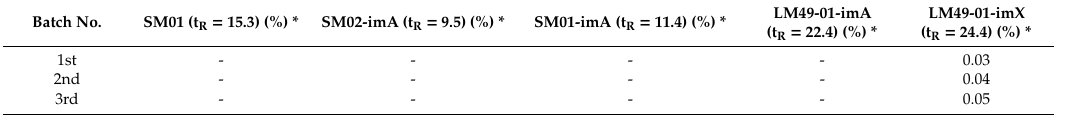
Table 8. The impurity profile of three batches for the Friedel–Crafts acylation step. Batch No.